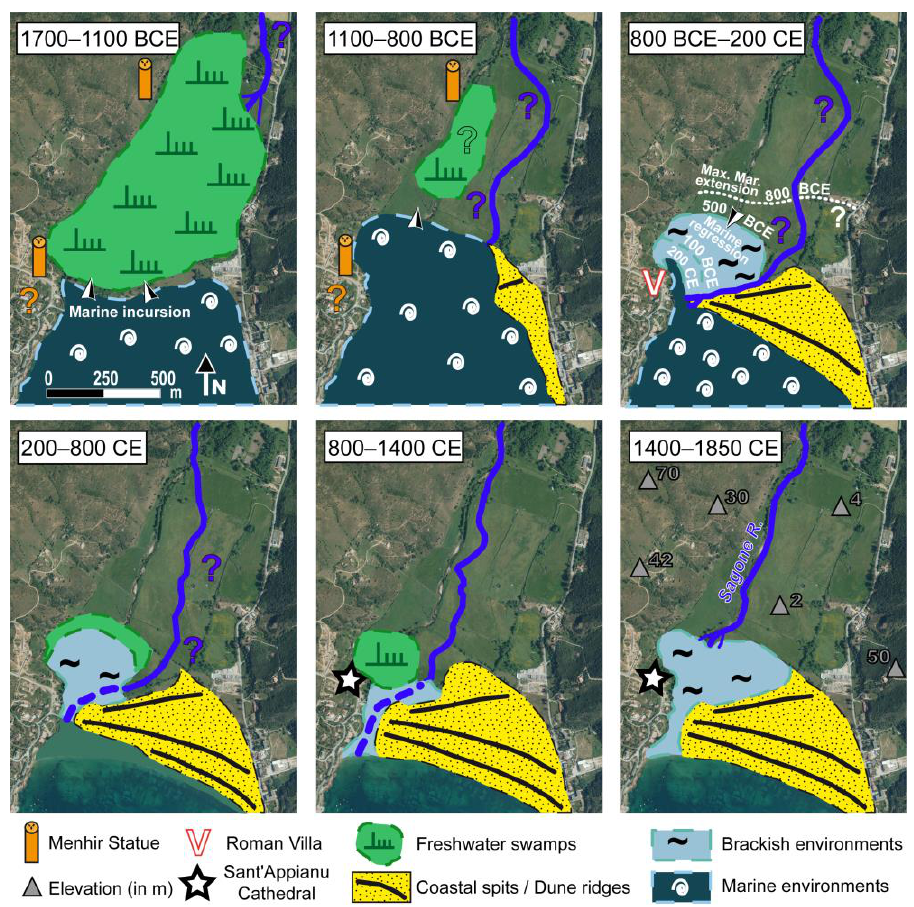
Figure 5. Palaeogeographic reconstruction of the Sagone Plain from the Bronze Age to Late Modern times. The interpretation is based on the combination of sedimentological data and ERT measurements obtained for the present study, together with the 1970s boreholes drilled for geotechnical purposes.